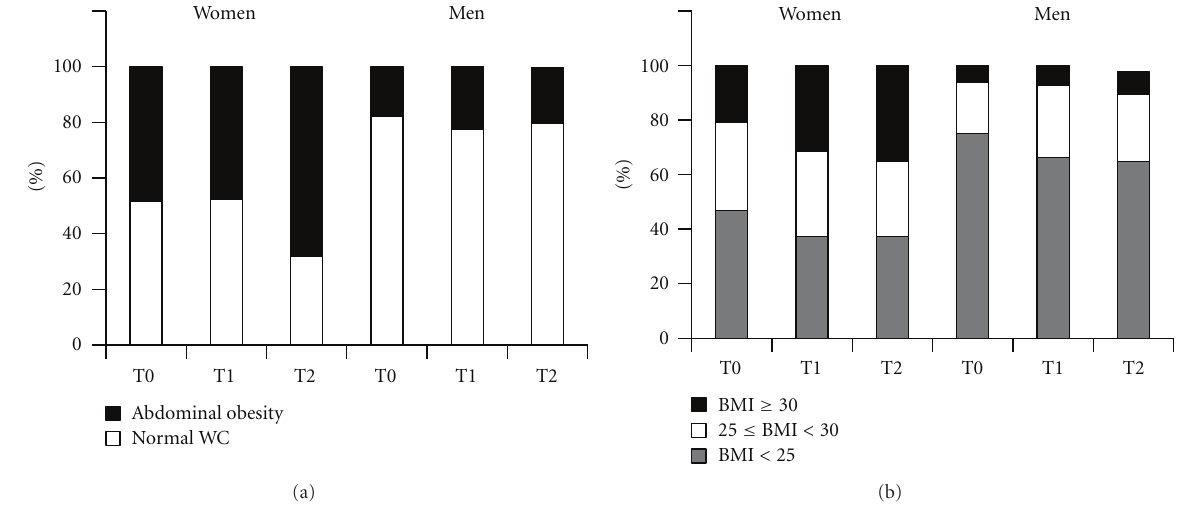
Figure 2: Changes in obesity status over the four-year followup period ( n =